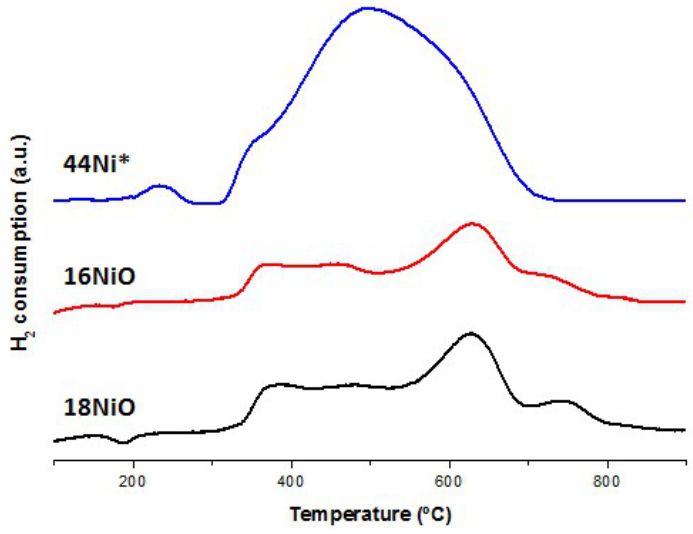
Figure 1. TPR profiles of the 16NiO, 18NiO and the non-reduced 44Ni* catalysts.